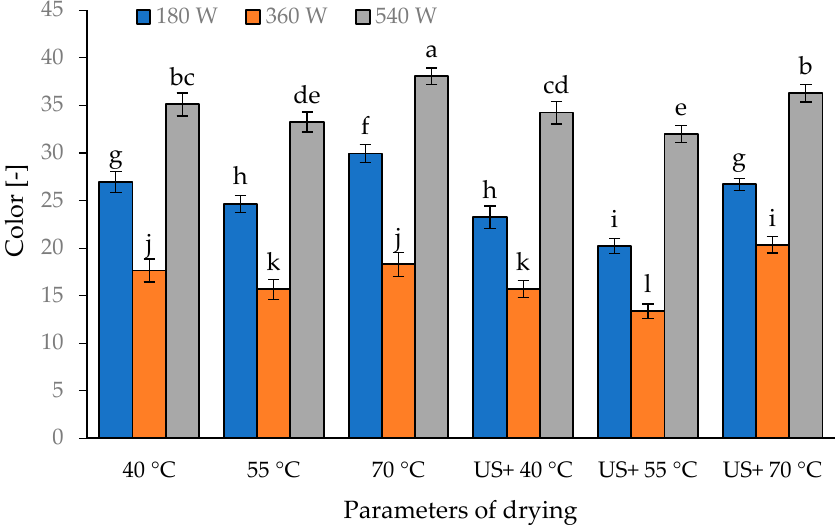
Figure 3. Effects of US pretreatment, MW power and air temperature during drying on total color difference ( ∆ E) in hawthorn. Data followed by different letters (a–l) in each column are significantly different at p < 0.01. Columns with the same letters are not significantly different.